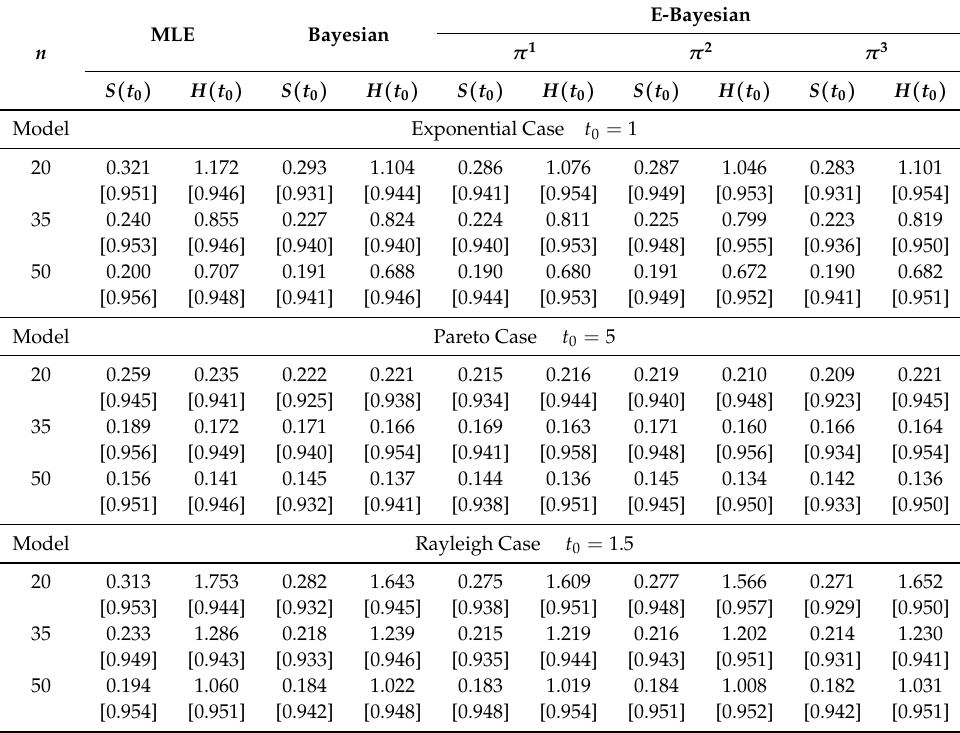
Table 9. The ALs and CPs (within bracket) of interval estimates with ( c 1 , c 2 , c 3 ) = ( 3,2.5,2 ) .